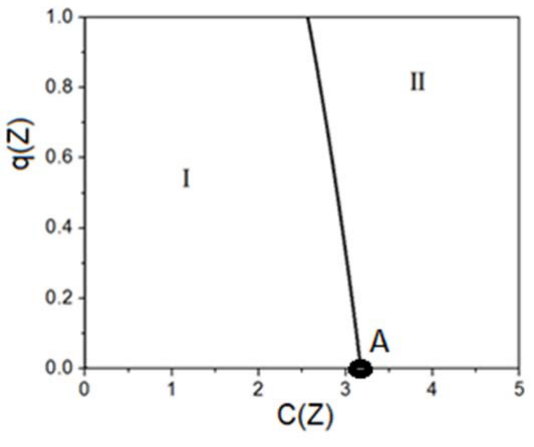
Figure 1 . The separatrice line in space